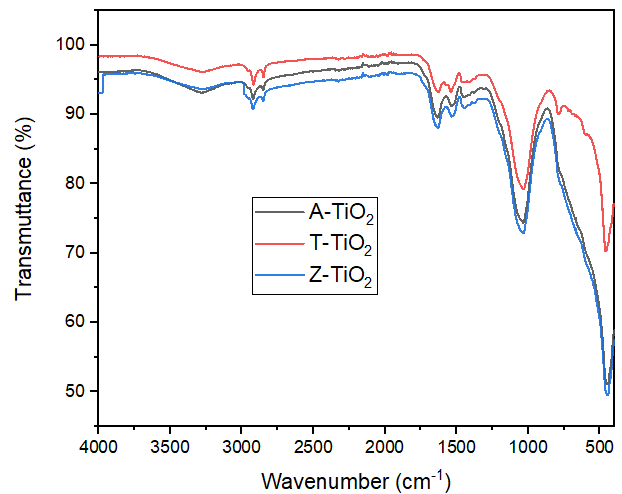
Figure 4. FTIR spectra of TiO 2 (red) < A–TiO 2 (black) < Z–TiO 2 (blue).